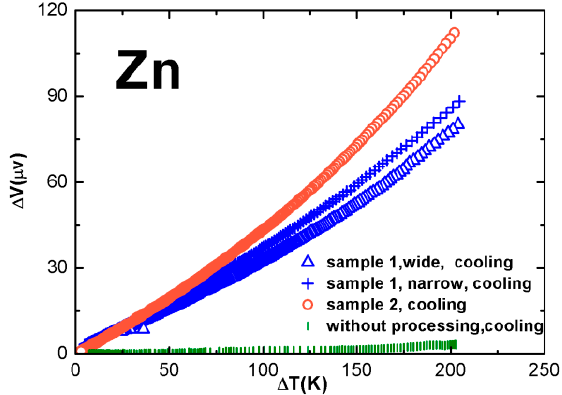
Figure 5. Measurement results of pressed samples made from one piece of 1.5 mm diameter Z wire.